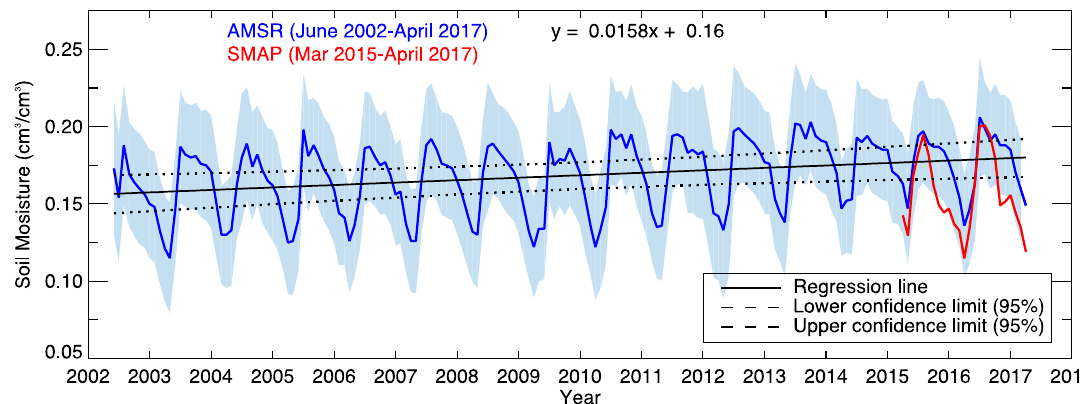
Figure 10. Monthly time series of AMSR soil moisture from June 2002 to April 2017. SMAP soil moisture soil moisture was also plotted for the period Mar 2015 to April 2017. Robust regression analysis was performed at the 95% confidence level to obtain the trend, which is shown by the dotted line. Shaded areas represent ±2 standard deviations associated with the mean monthly soil moisture.